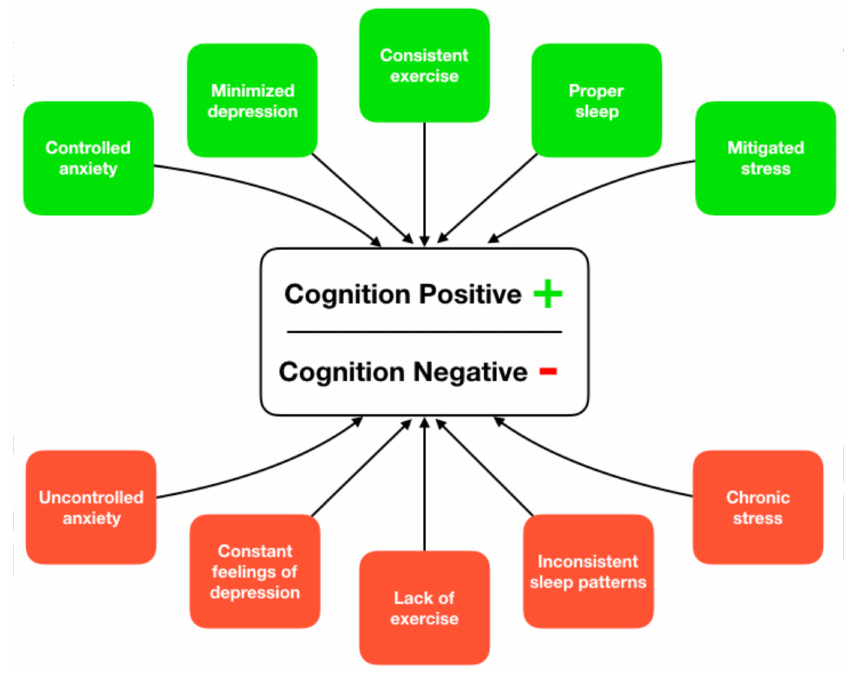
Figure 1. Supported paths to ameliorate or increase risk of cognitive decline through lifestyle-based